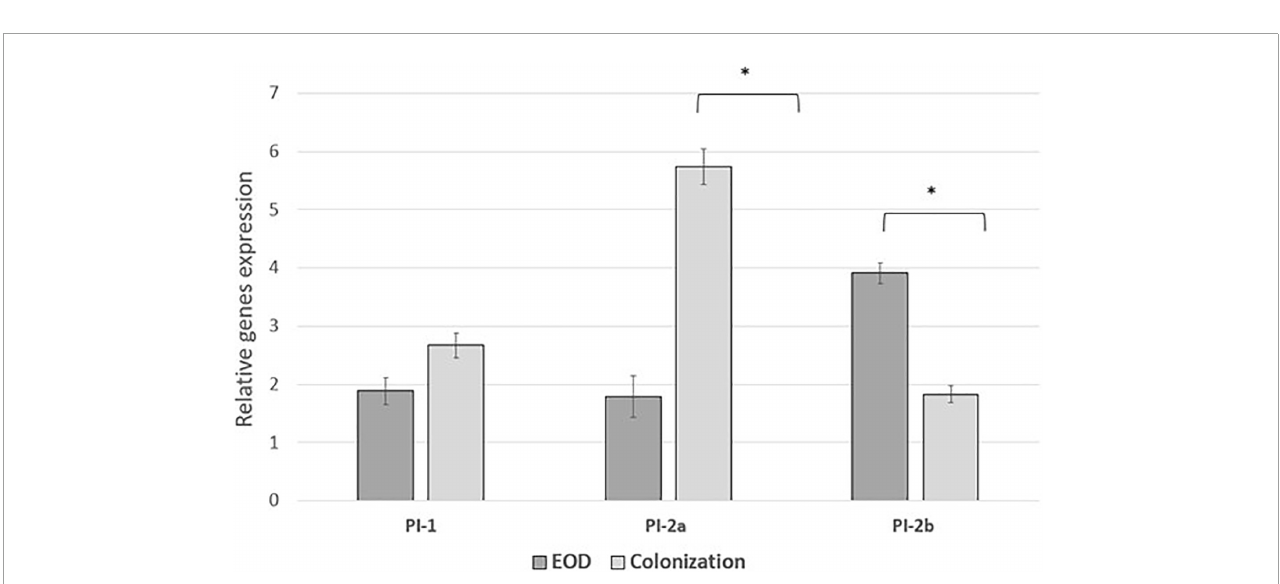
FIGURE5 The expression of pili islands gene in early-onset disease (EOD) and colonizing group B streptococcus (GBS) isolates from Mayanei Hayeshua Medical Center (MHMC) were analyzed by qRT-PCR. Amounts of each transcript were normalized to the rpoB gene and expressed relative to this gene in reference strain ATCC BAA611. The expression level of ATCC BAA611 strain was defined as 1. Columns represent the relative mRNA expression level of each gene from each strain. Values are represented as mean ± SD ( n = 8) from three independent qRT-PCR experiments. Error bar show SD. Asterisk indicates a significant difference ( ∗ p < 0.05 by t